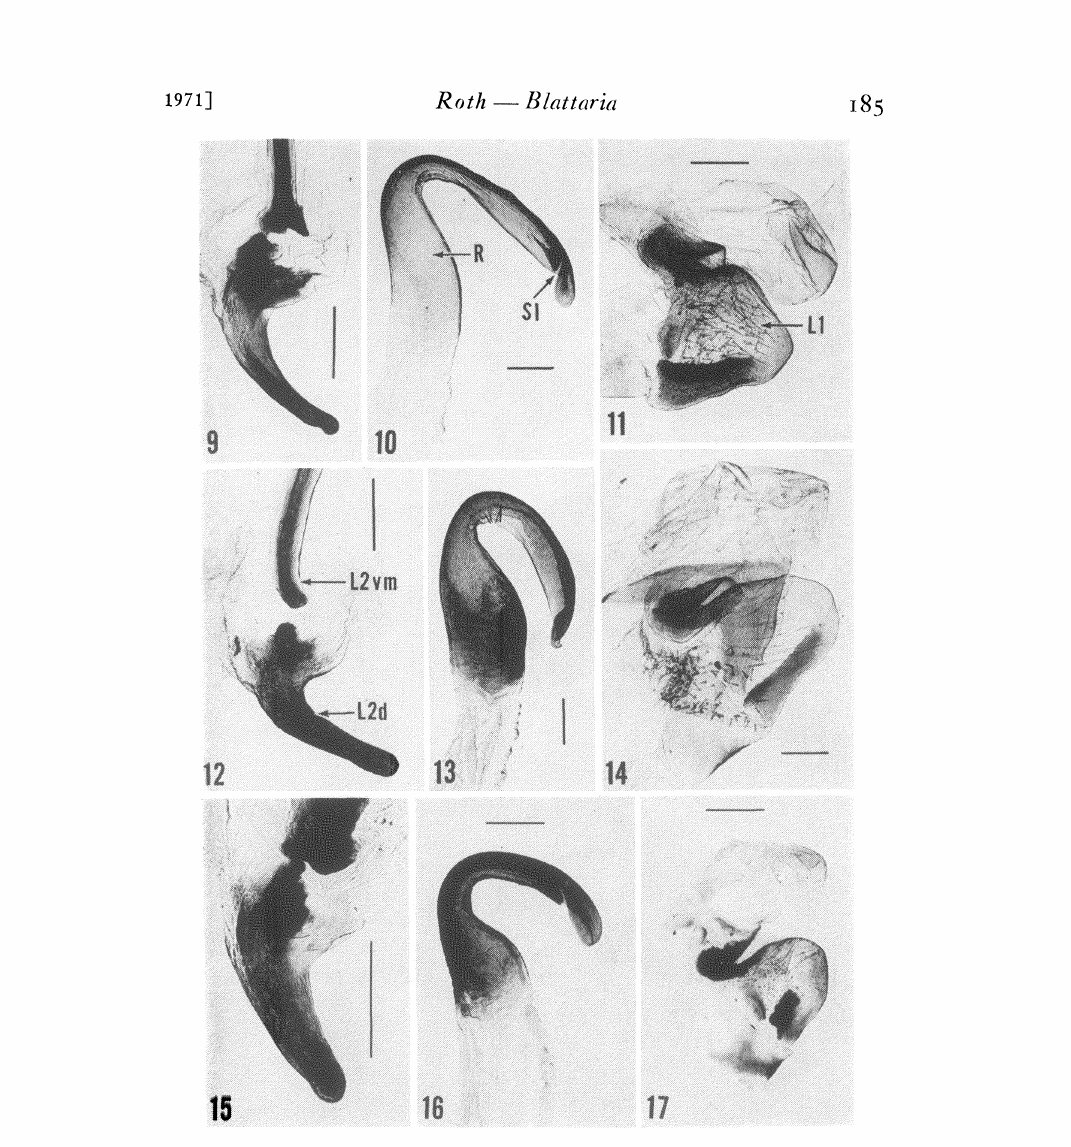
Figs. 9-17. Cockroach male genitalia of Epilamprinae (Poroblattini). 9-11. (118 ANSP). Poroblatta sp. (from specimen shown in Fig. 1). 12-14. (116 ANSP). Colapteroblatta compsa (from specimen shown in Fig. 2). 15-17. Nauclidas nigra. (from adventive on bananas probably originating in the West Indies; specimen from a small culture established at the British Museum). (L1 first sclerite of left phallomere; L2vm median sclerite; L2d dorsal sclerite of L2; R2 hooked sclerite of right phallo- mere; SI subapical incision). (scale 0.3